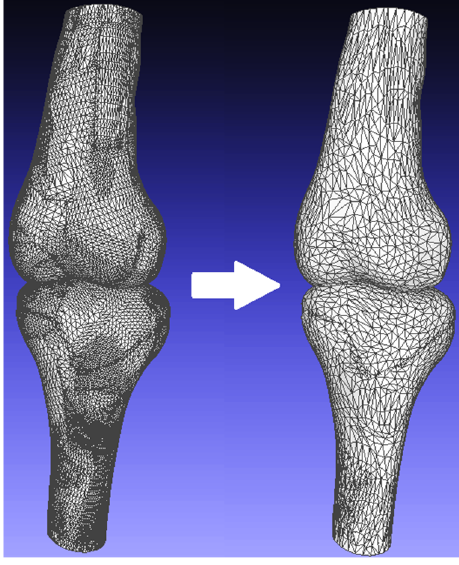
Figure 1. Model geometry simplification and smoothening using MeshLab.